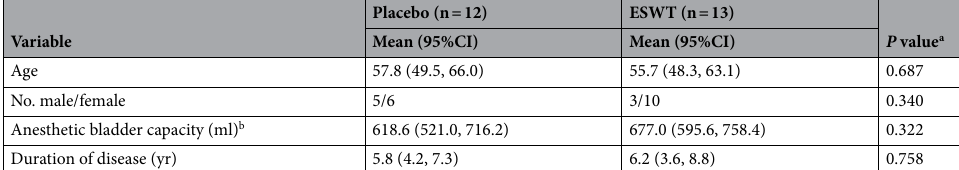
Table 1. Baseline patient characteristics. Values are presented as mean (95%CI). * P < 0.05, ** P < 0.01, *** P < 0.005, **** P < 0.0001. a Comparison between ESWT and placebo (Two sample t-test). b During